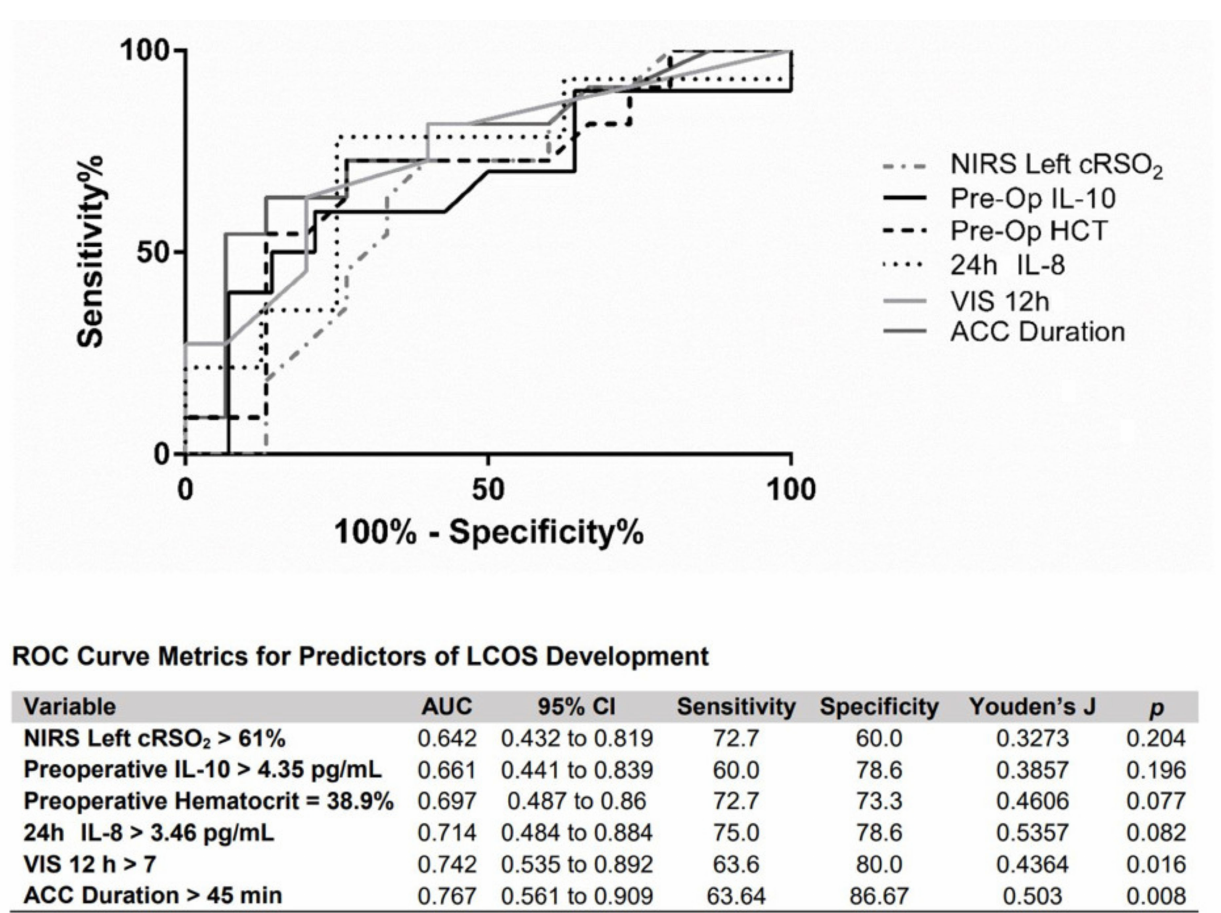
Figure 4. Performance of receiver operating characteristic (ROC) curves, representing the percentage of true positives (sensitivity) against the percentage of false positives (100% specificity), for clinical and laboratory variables potentially predicting the development of